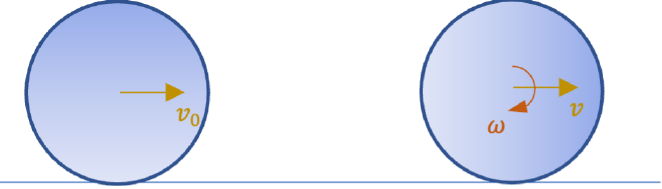
Figure A1. Particle sliding on a wall with initial velocity v 0 . Due to attrition, the translational energy is progressively converted into rotational